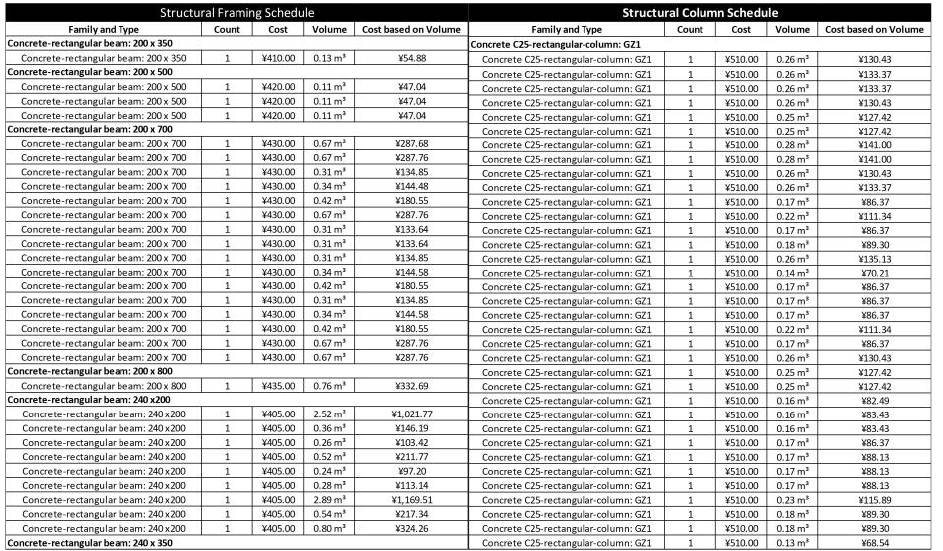
13 of 20 Figure 10. Exterior rendering images.